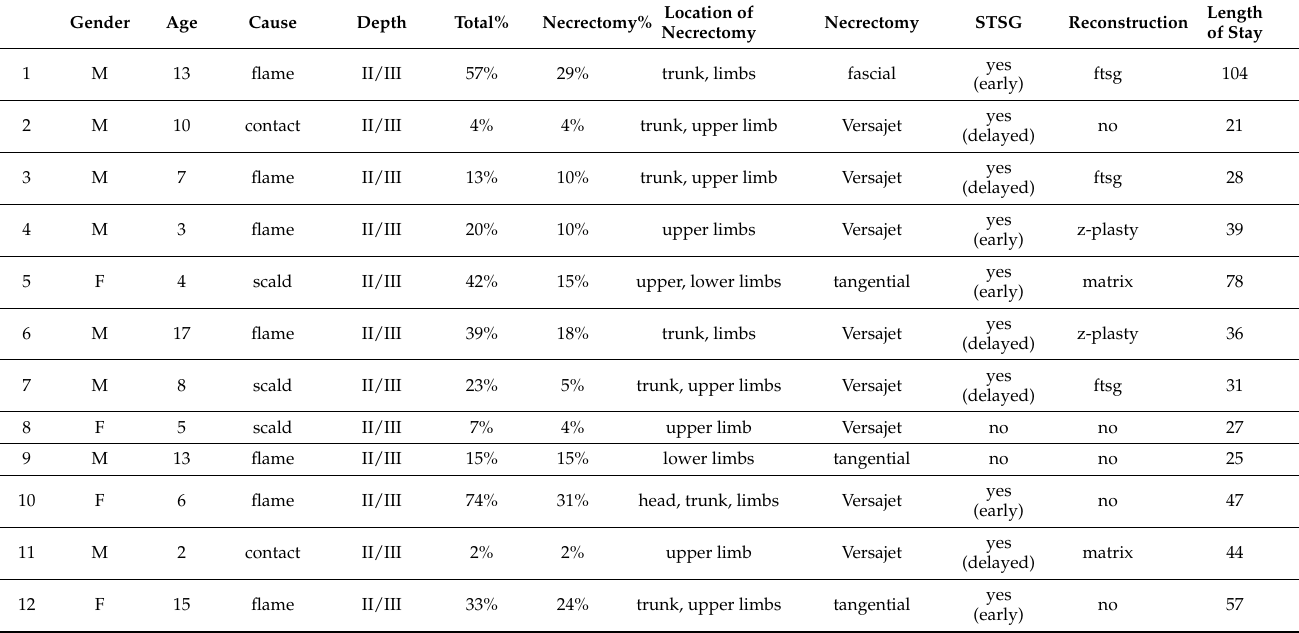
Table 2. Characteristic of the SoC group treated